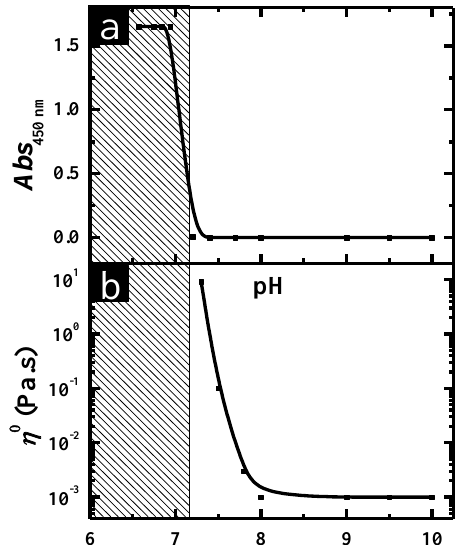
Figure 9. ( a ) Turbidity and ( b ) zero-shear viscosity η o of C 12 C 3 C 12 (SO 3 ) 2 /CTAB solutions plotted against pH at X g = 0.70 and C T = 20.0 mM.